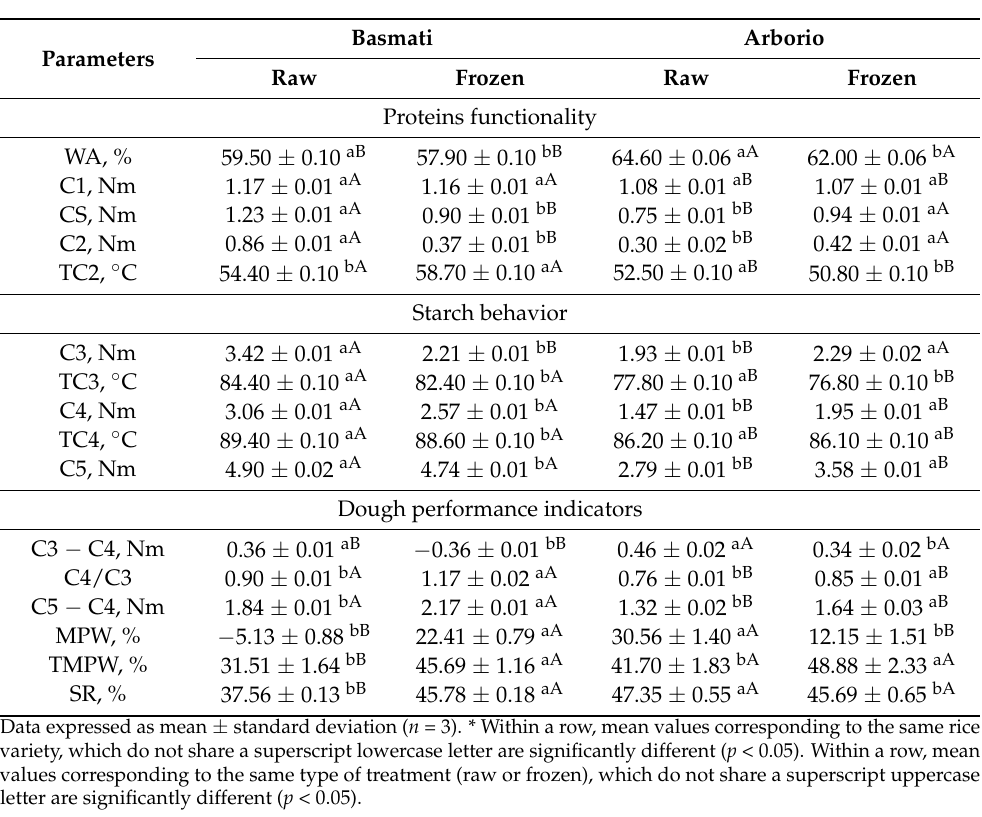
Table 6. Thermo-mechanical properties of rice flours obtained from raw and frozen Basmati and Arborio rice.